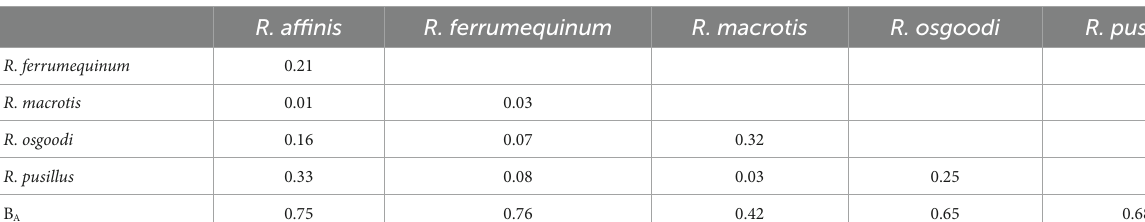
TABLE 1 Breadth of trophic niches and dietary overlap between five rhinolophid bats. B A : standardized Levins’ measure of niche breadth. For the dietary overlap index, values range from 0 (no dietary overlap) to 1 (full dietary overlap).